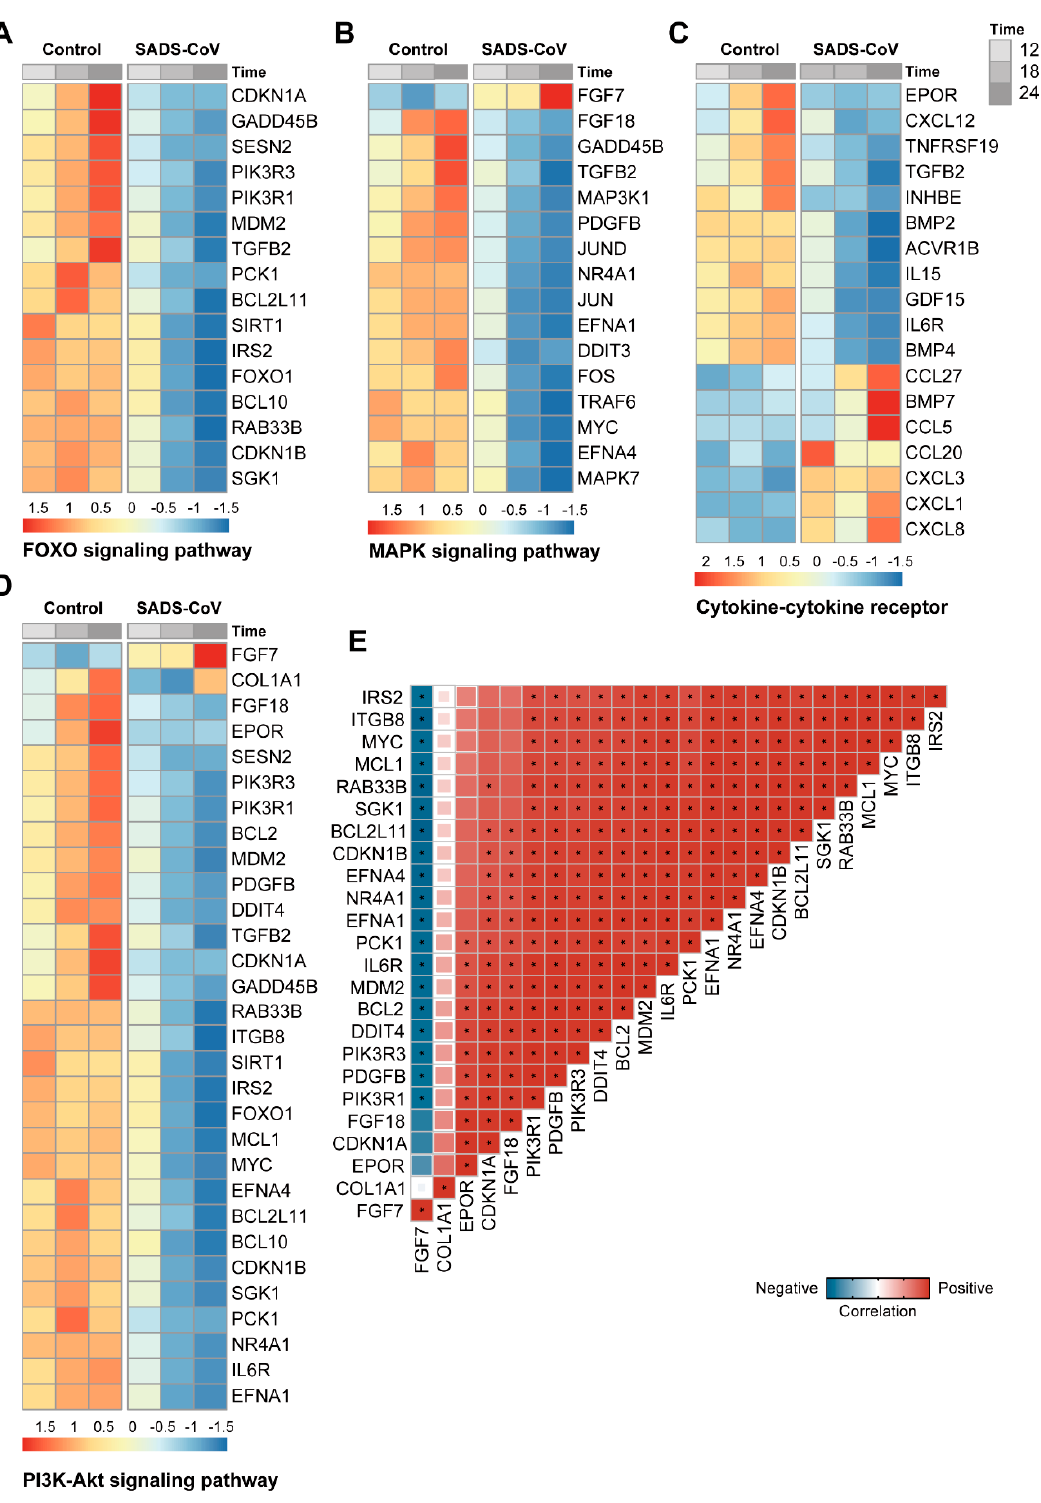
Figure 6. ( A – D ): Heatmap shows the fold change of genes in four KEGG pathways in SADS-CoV-infected cells compared with mock-infected cells at 12, 18, and 24 hpi. ( E ): Correlation plot shows the correlations between genes enriched in PI3K-Akt signaling pathway. The color and size of square denote the correlation coefficient between two genes and * represents p -value of correlation >0.05.